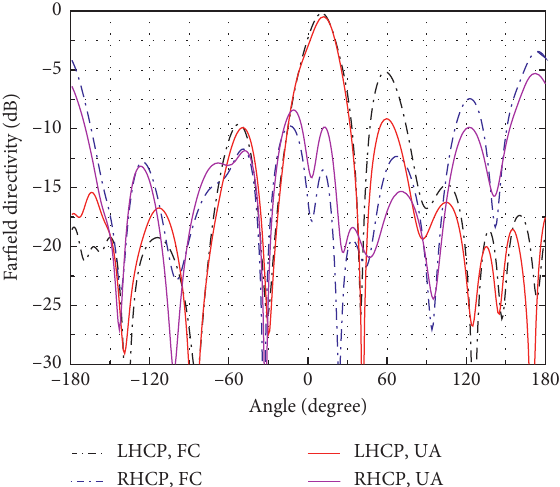
Figure 8: Simulated radiation patterns at 31GHz of the proposed array with different feeding networks.